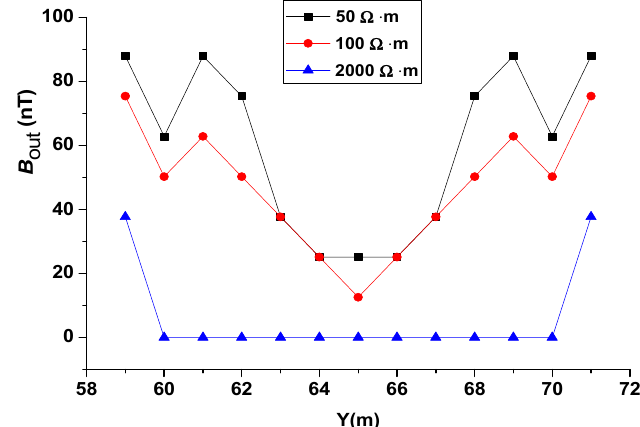
Figure 13. The secondary field intensity along the survey line above the #6 conductor with different soil resistivities.